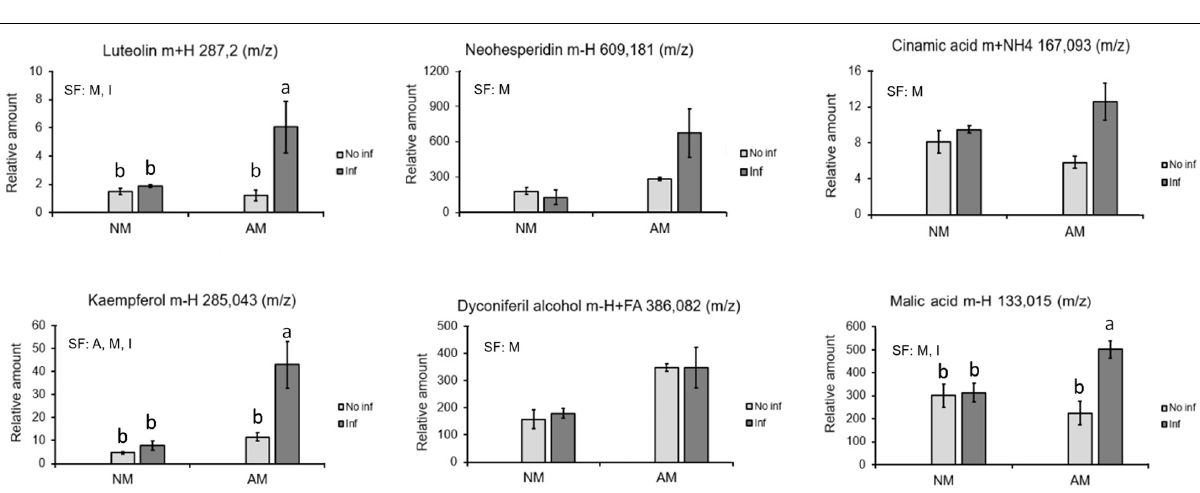
FIGURE 7 | Identified compounds displaying a priming profile in mycorrhizal C. aurantium plants 48 h after T. urticae infestation. Four different treatments were employed in all the cases: NM: non-mycorrhizal SO plants. AM: mycorrhizal SO non-infested plants. NM inf: non-mycorrhizal infested plants. AM inf: mycorrhizal infested plants. Compounds were identified using exact mass and fragmentation spectrum. Peak intensity was obtained by using MarVis filter and cluster following a Kruskal–Wallis test ( P < 0.05). Relative amount of the metabolites was determined by normalizing the chromatographic area of each compound with the dry weight of its sample. Data was presented as a mean of five replicates ± SD (n = 5). Significant factors (SF) indicate if the two independent factors: A (Arbuscular Mycorrhizal), M (Mite infestation) and/or their interaction I (A × M) were statistically significant (Two-way ANOVA, P < 0.05). Different letters indicate significative differences (Tukey HSD test, P < 0.05). The stats of analysis are provided in Supplementary Table 1